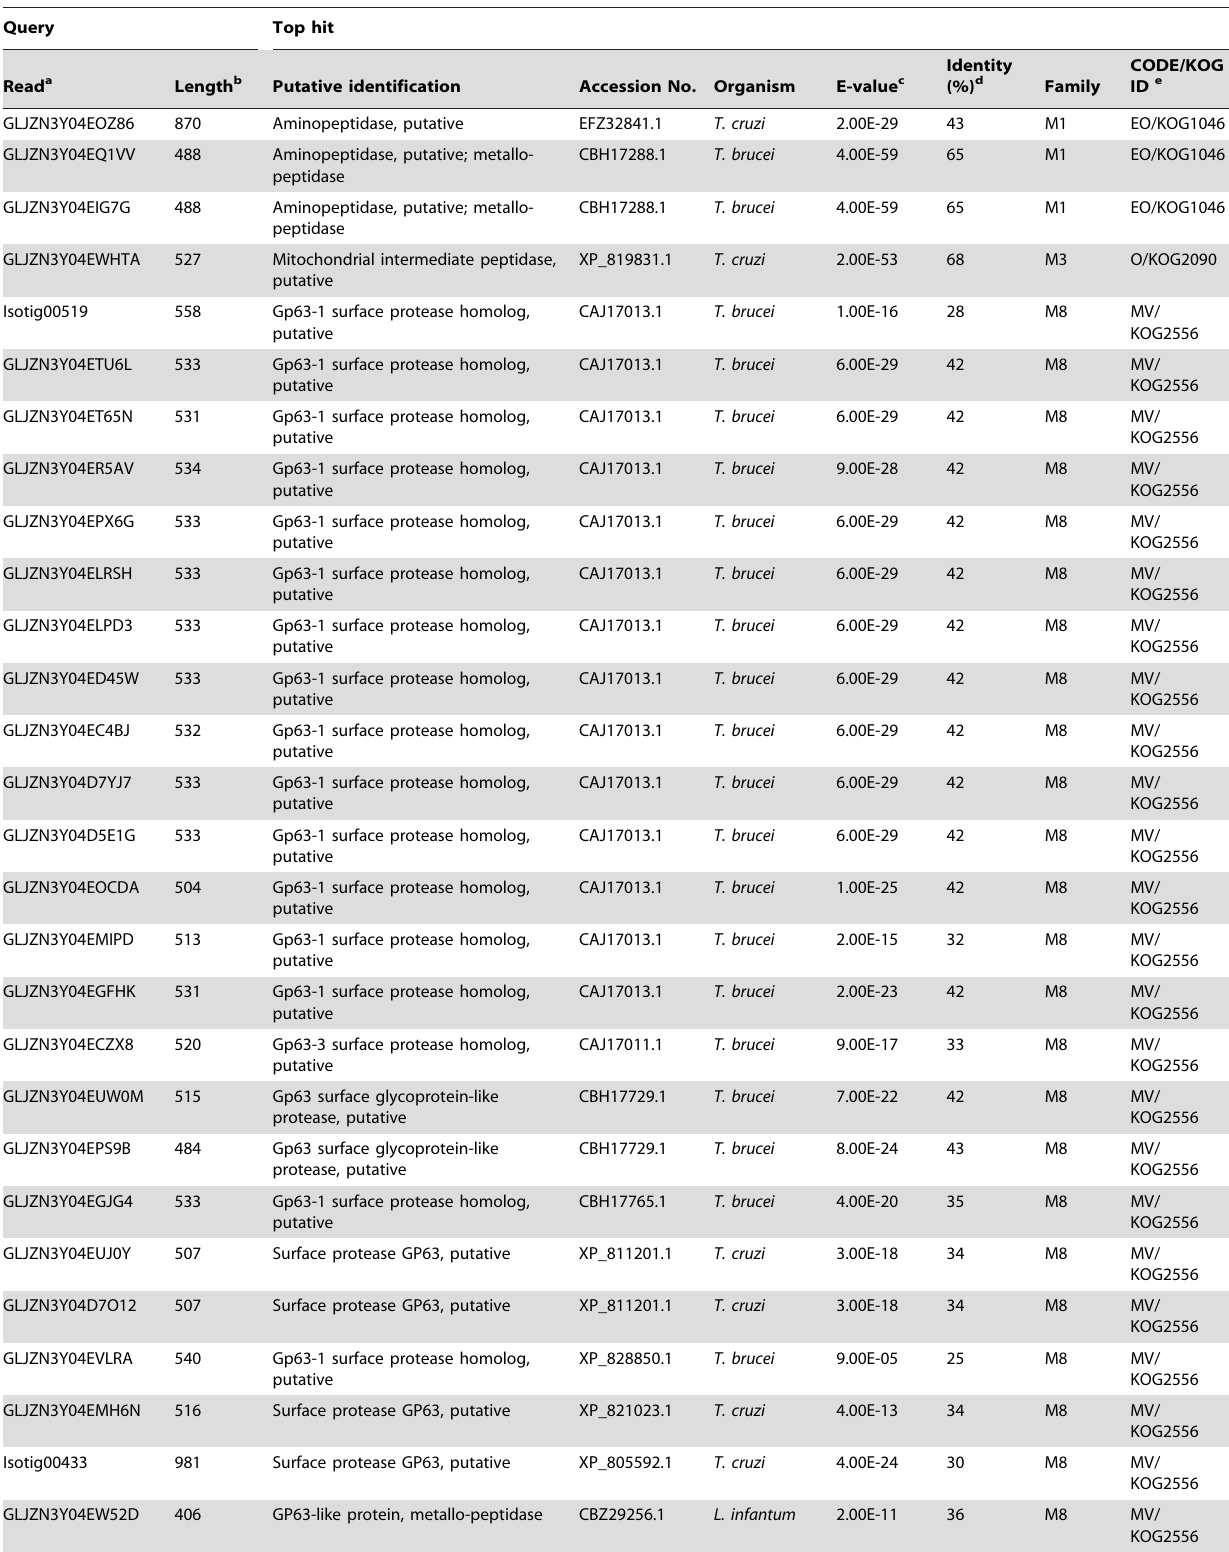
Table 3. Putative transcripts encoding metalloproteases or GP63 protease of the Kinetoplastida.